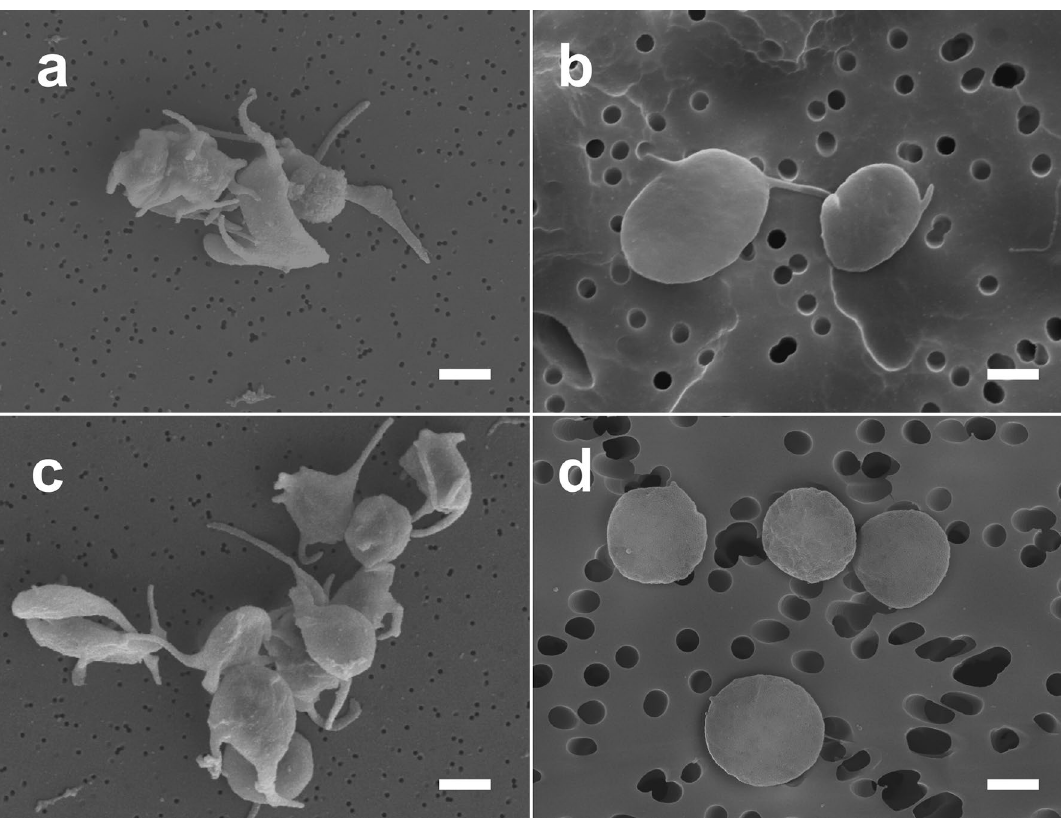
Figure 4. Representative scanning electron micrographs of activated ( a,c ) and resting platelets ( b,d ). Platelets isolated from the blood of COVID-19 patients ( a – c ) and a healthy donor ( d ). Magnification bars: 1